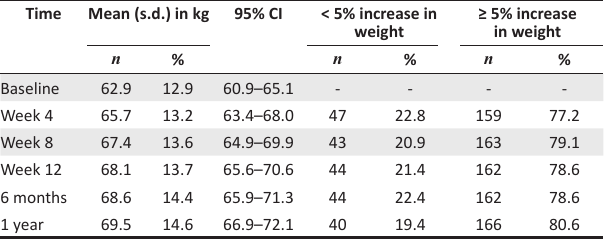
TABLE 3: Description of weight changes across the intervals of follow-up. Time Mean (s.d.) in kg